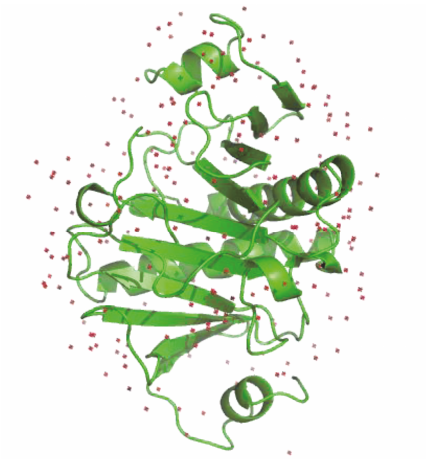
Figure 2: Crystal di ff raction pattern of the HINT1 protein. HINT1 consists of a homodimer, each subunit of which contains two α -helices and three β -sheets. From